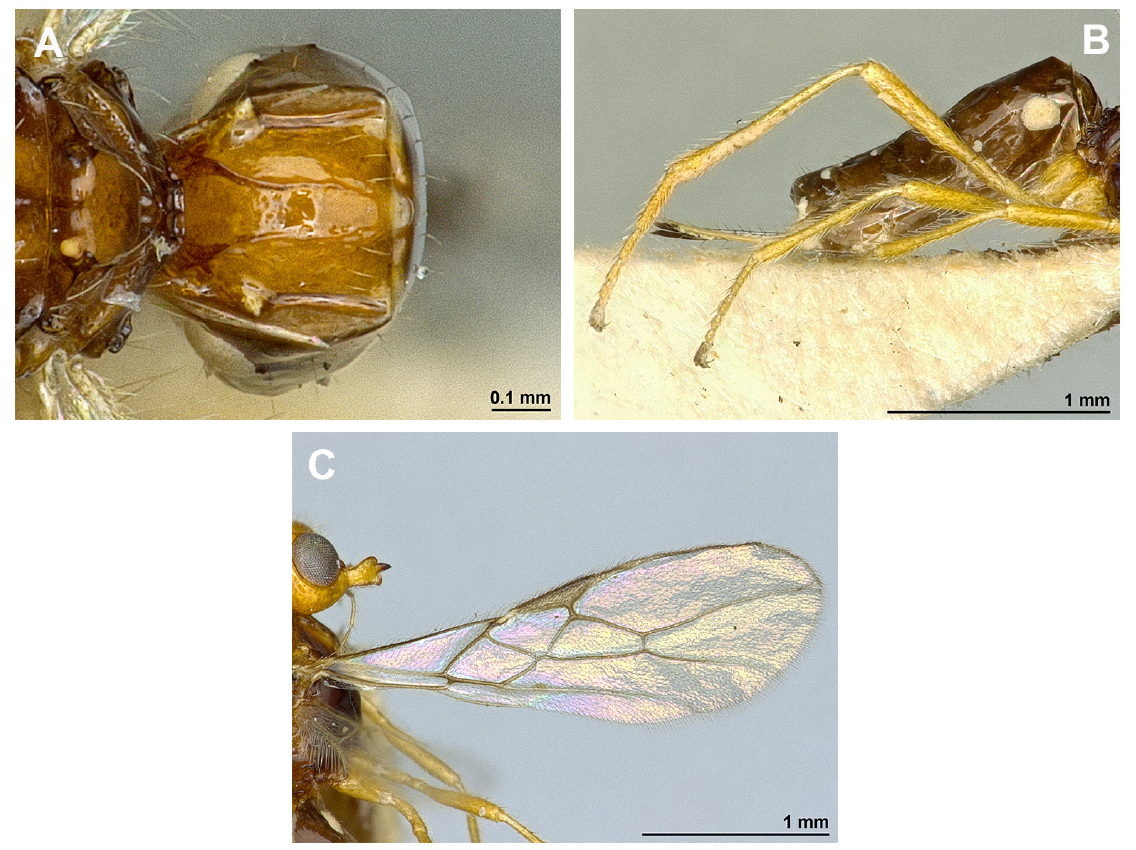
Fig. 28. Asobara kawandensis Peris-Felipo, sp. nov., ♀, holotype (BMNH). A . First metasomal tergite, dorsal view. B . Hind leg, metasoma and ovipositor, lateral view. C . Fore